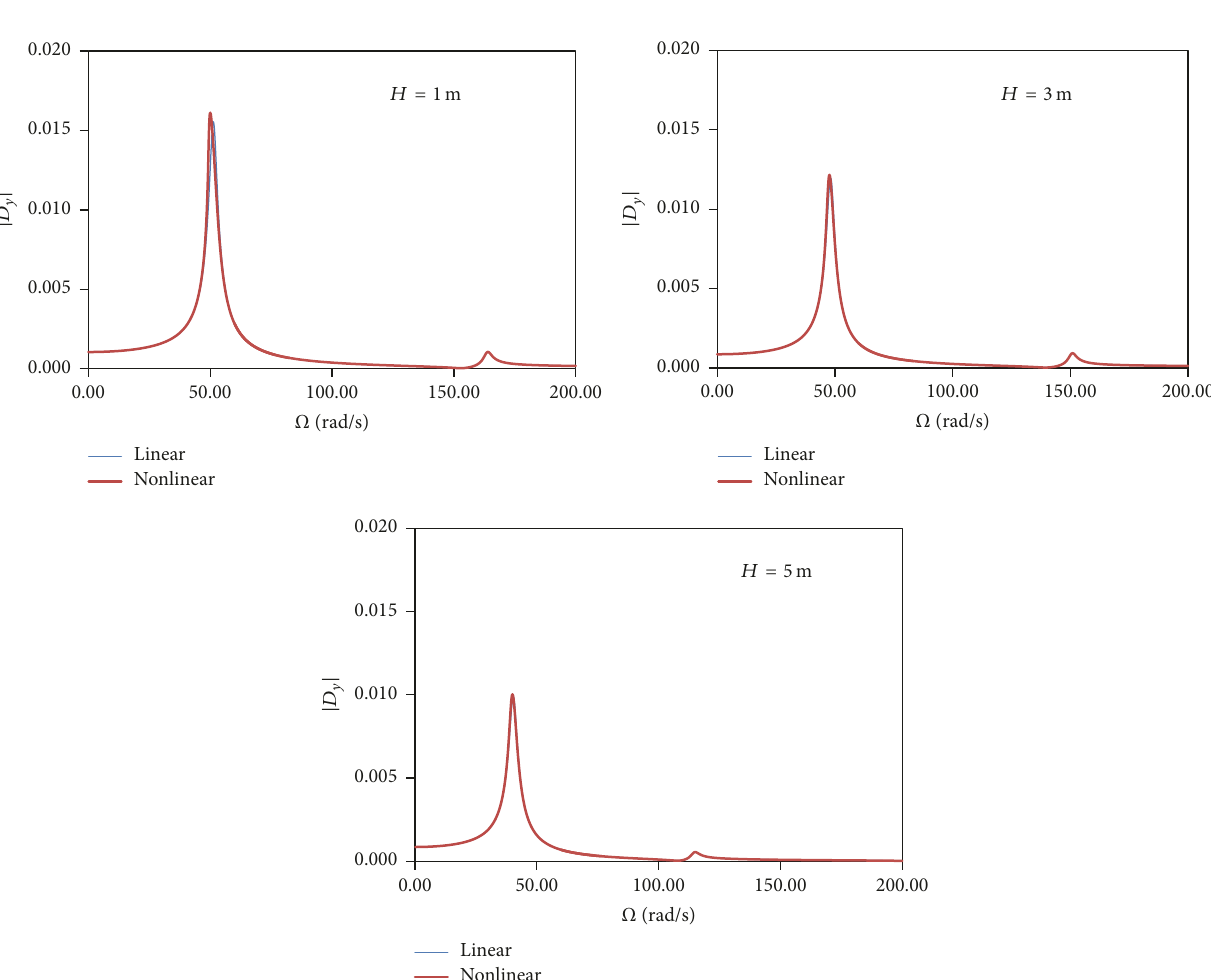
Table 2: Natural vibration frequencies of the arched-roof frame. 𝐻